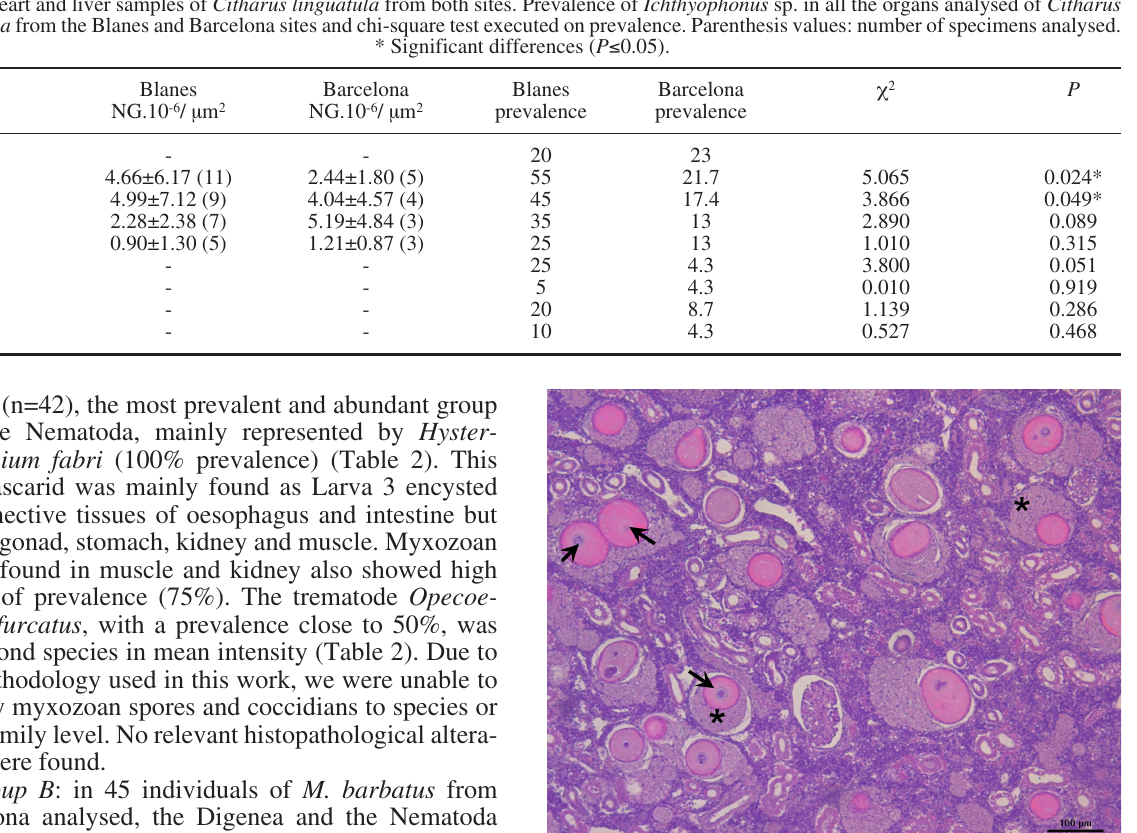
Table 3. – Average number of granulomas (NG) of Ichthyophonus sp. per unit area counted in 5 fields of view from each section of kidney, spleen, heart and liver samples of Citharus linguatula from both sites. Prevalence of Ichthyophonus sp. in all the organs analysed of Citharus